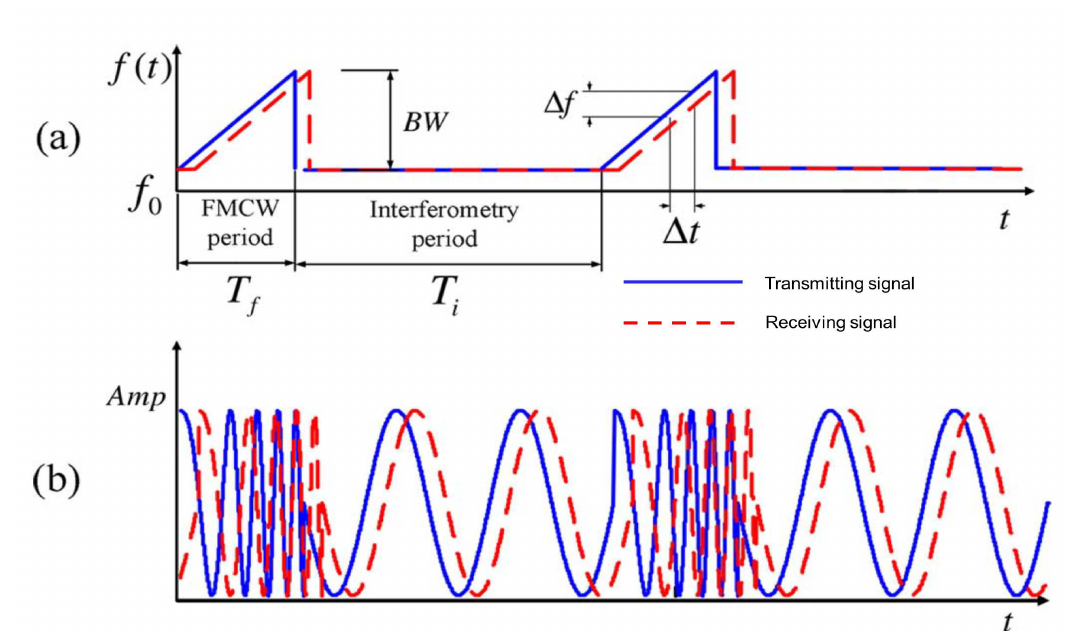
Figure 12. Transmitting and receiving signal of the FMCW - CW radar in the ( a ) frequency domain and ( b ) time domain